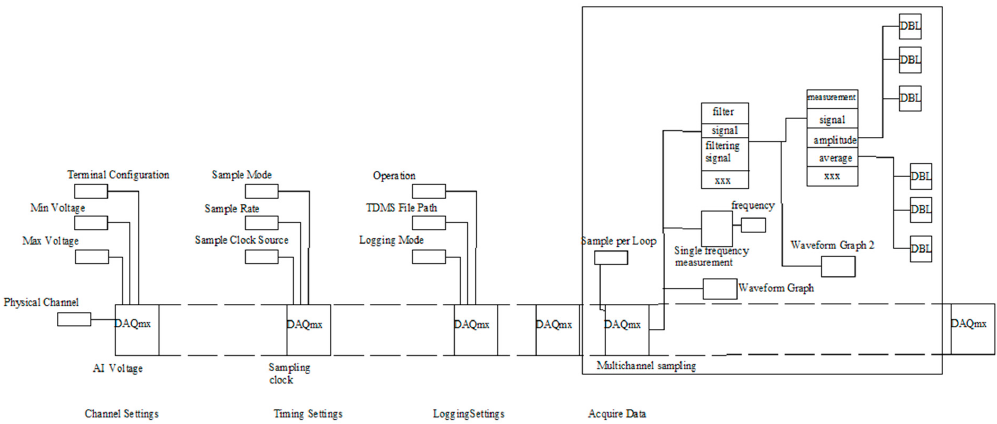
Figure 8. Acquisition device — NATIONAL INSTRUMENTS BNC-2111.